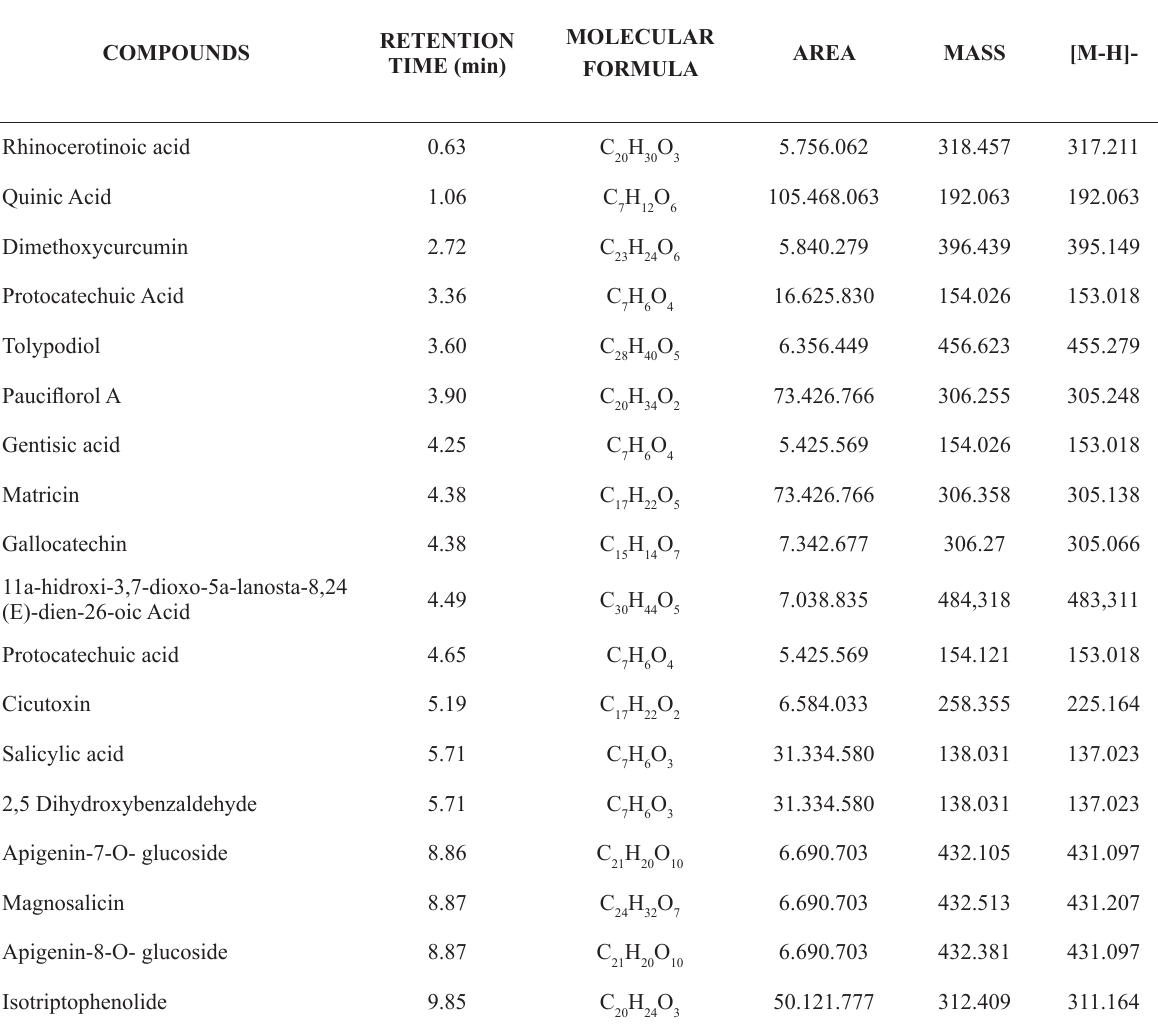
UPLC-MS spectral analysis of compounds found in saline extract from M. emarginata leaves. MOLECULAR RETENTION AREA COMPOUNDS TIME (min) FORMULA